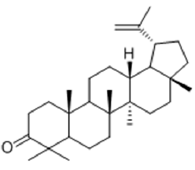
Figure 25. Structure of lupenone isolated from leaf effects extracts of Erica multiflora .